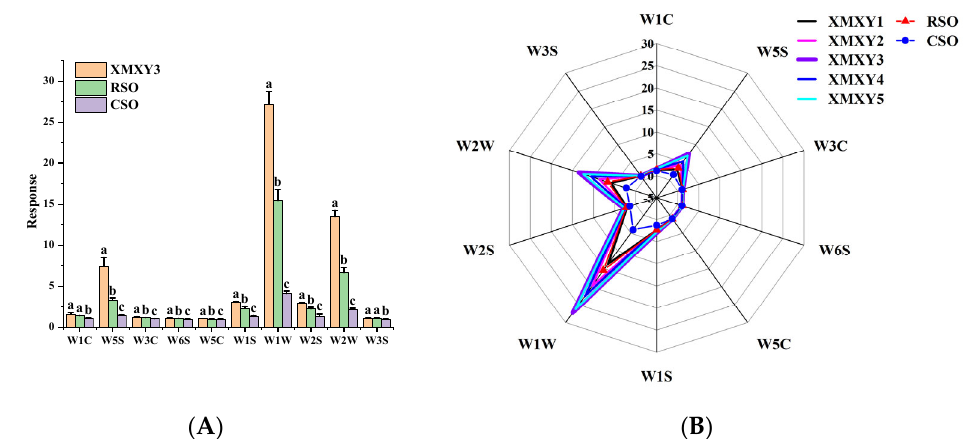
Figure 3. ( A ) Radar chart, different superscripts indicate statistically significant different values ( p < 0.05); ( B ) analysis of the E-nose response data. XMXY1–5: Xiao Mo Xiang You 1–5; RSO: roasted sesame oil; CSO: cold-pressed sesame oil.